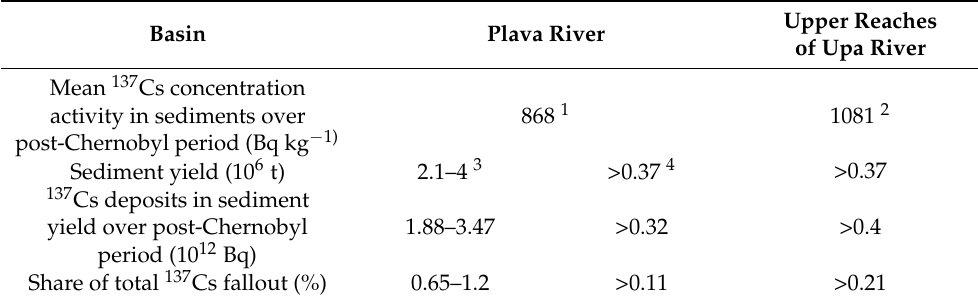
Table 9. Evaluation of particulate 137 Cs deposits transferred with sediment yield beyond Plava River and Upper Reaches of Upa